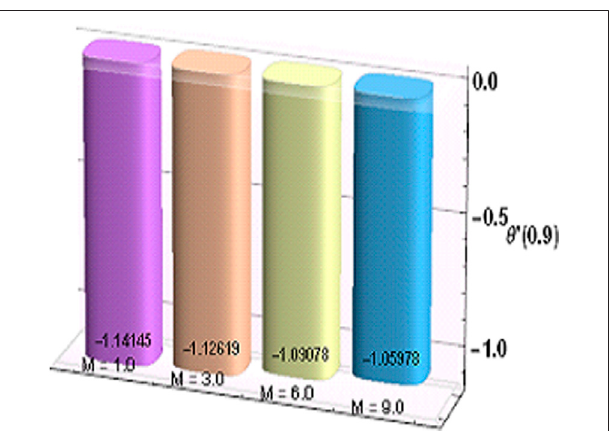
FIGURE 21 | Temperature for magnetic parameter at r (cid:1) 0.3 .